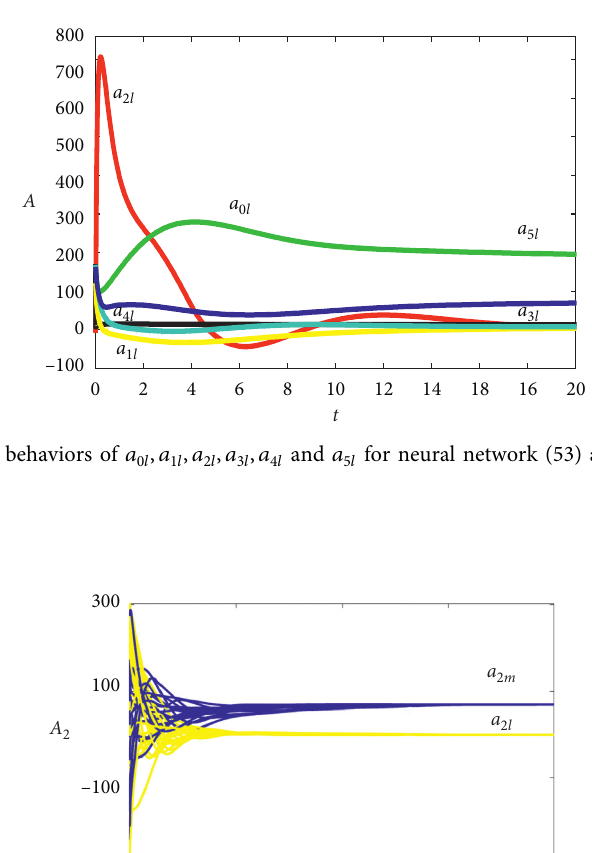
Figure 13: Transient behaviors of A for neural network (53) and (54) with 20 various initial points in Example 9. 2